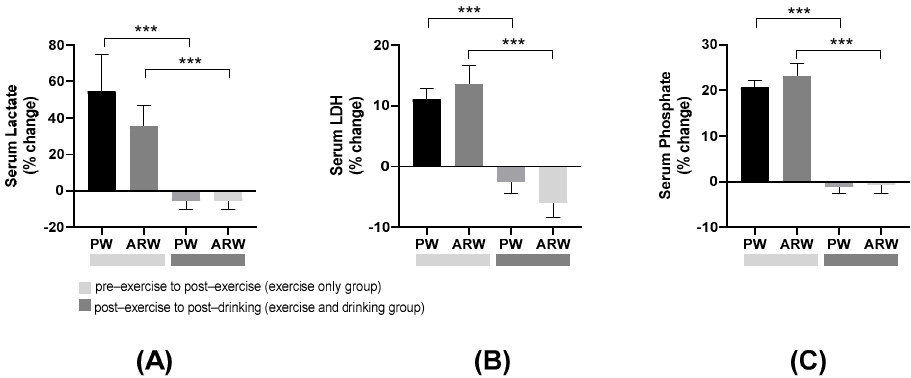
Figure 4. Effects of ARW consumption on lactate and LDH levels of healthy individuals after intense exercise. Blood was collected from the participants pre- and post-exercise. Participants consumed PW or ARW after exercise and blood was collected. Fold changes in the serum levels of lactate ( A ), LDH ( B ), and phosphate ( C ) were calculated pre- to post-exercise and post-exercise to post-drinking. Statistical significance was analyzed via a one-way ANOVA (Mann–Whitney U test). *** p < 0.001. Abbreviations: LDH, lactate dehydrogenase; PW, purified water; ARW, alkaline reduced